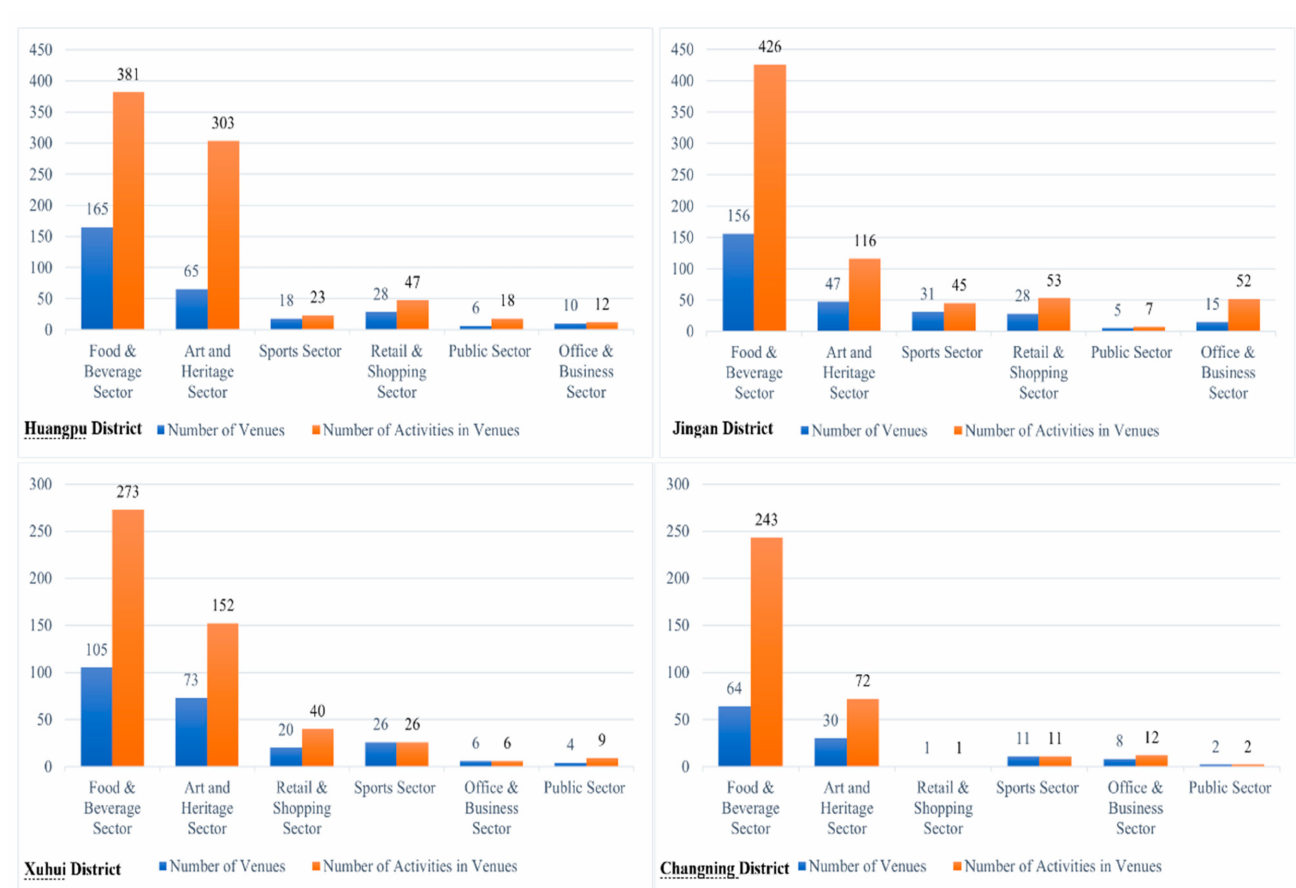
Figure 4. Functional breakdown of cultural venues in Huangpu, Jingan, Changning, and Xuhui